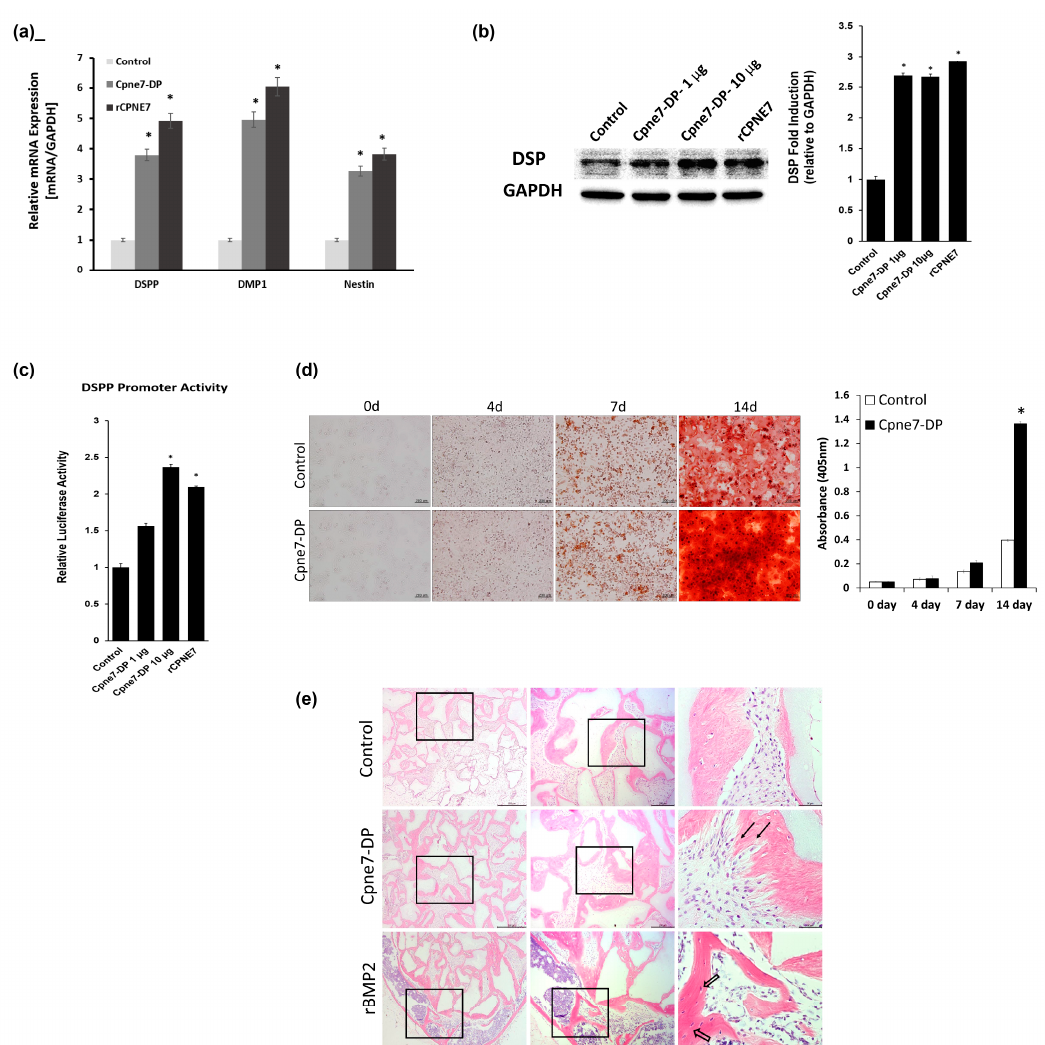
Figure 3. Functional peptide, Cpne7-DP upregulates odontoblast differentiation markers in vitro and induces dentin-like tissue formation ex vivo. ( a ) Real-time PCR analysis of DSPP, DMP1, and Nestin mRNA in hDPCs treated with Cpne7-DP or rCPNE7. ( b ) Western blotting and semi-quantification analysis of DSP expression in hDPCs treated with Cpne7-DP 1 µg, 10 µg or rCPNE7. ( c ) Transcriptional activity of dentin sialophosphoprotein (dspp) promoter was evaluated by luciferase assay in MDPC-23 cells treated with Cpne7-DP 1 µg, 10 µg or rCPNE7. ( d ) Effects of Cpne7-DP on the mineralized nodule formation of MDPC-23 cells in vitro analyzed by alizarin red S staining and corresponding semi-quantification. ( e ) Histological analysis of the subcutaneously transplanted 100 mg HA/TCP particles alone or with Cpne7-DP or rBMP2 in a 0.5% fibrin gel into immunocompromised mice for 12 weeks. Samples were stained with hematoxylin-eosin. Arrows indicate dentinal tubule-like structures; empty arrows indicate lacunae-containing osteocyte-like cells. All values represent the mean ± standard deviation of triplicate experiments. * p < 0.05 compared with control. GAPDH, glyceraldehyde 3-phosphate dehydrogenase.